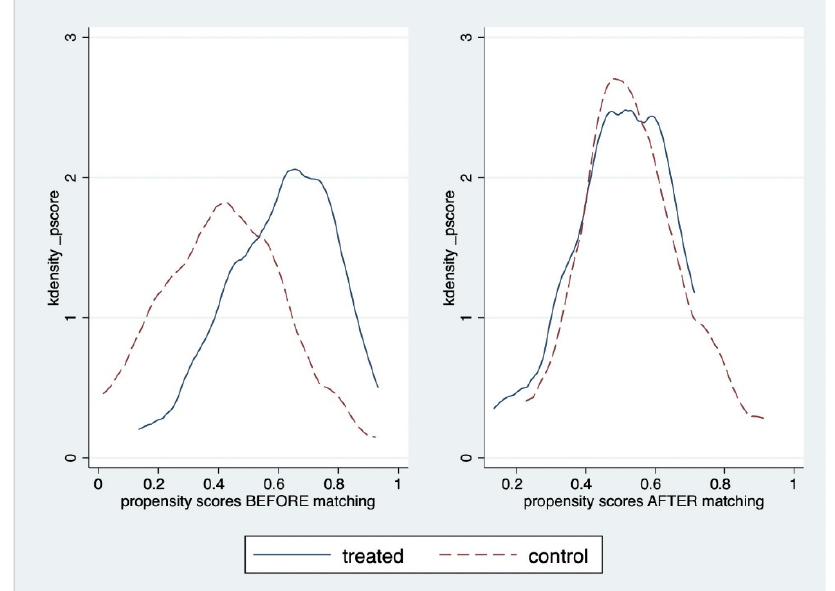
Figure 3. Propensity score distribution between intervention and control groups before and after matching.